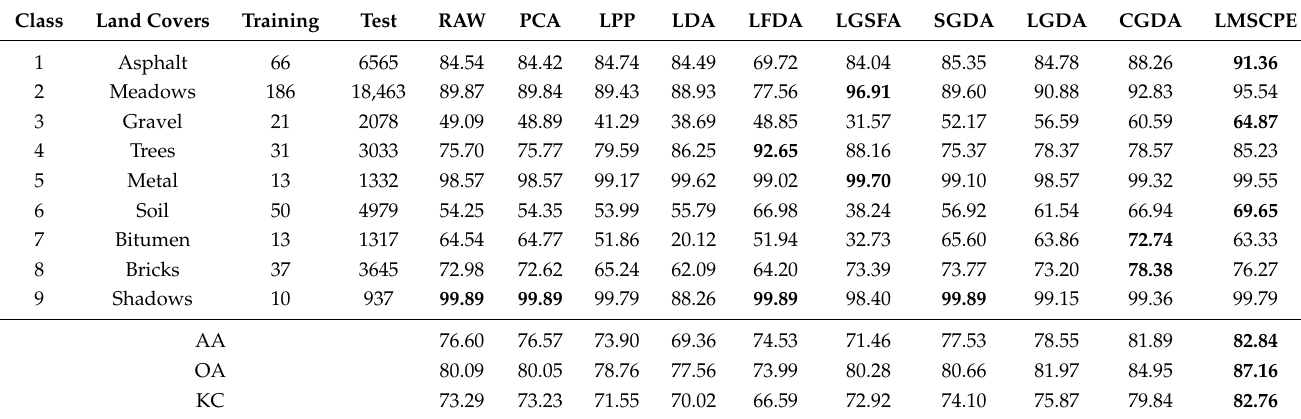
Table 4. Classification results (%) of each type of land covers (t = 1%) with the nearest neighbor (NN) classifier on the PaviaU data set. (AA—average classification accuracy, OA—overall classification accuracy, KC—kappa coefficient, and the best results of a row are marked in bold).